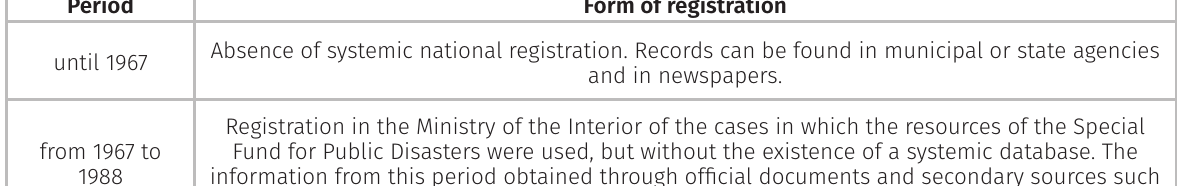
Table III. Evolution of the registry on natural disasters in Brazil. Period Form of